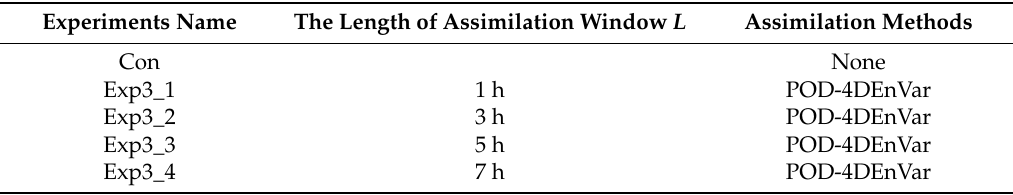
Table 7. Experimental design for assimilation window sensitivity experiments.